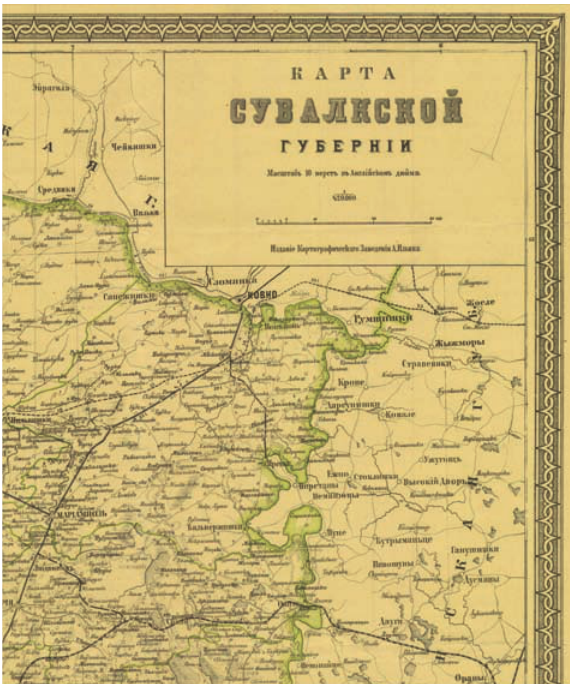
Fig. 2. Fragment of map Suvalkija